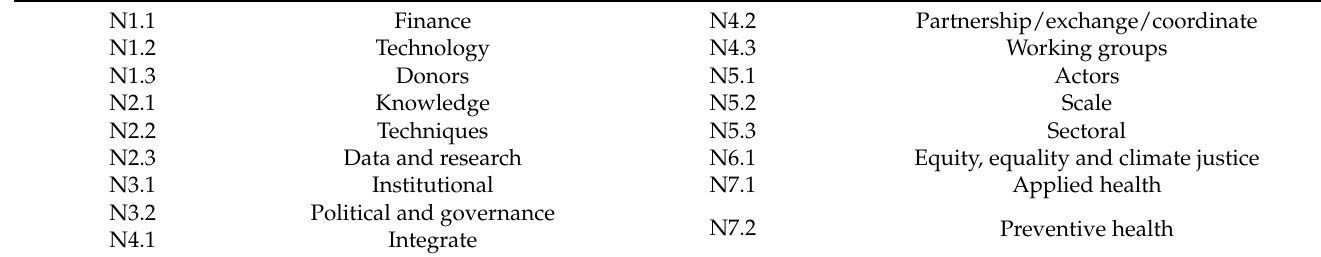
Table 2. Need factors grouped into